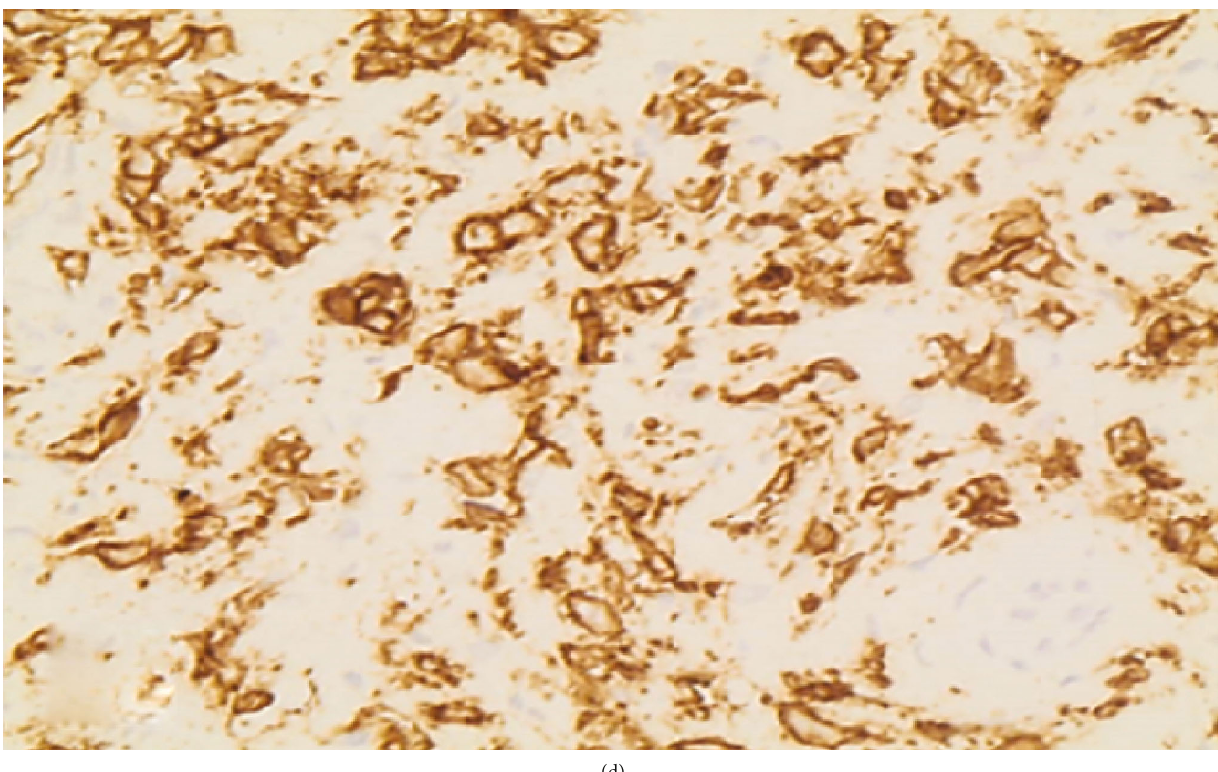
Figure 1: Pathology examination. (a) EE 4x; (b) 4x, immunohistochemical for CK, AE1-AE3: esocervical epithelium is strongly positive; (c) EE 10x, di ff use proliferation of large lymphoid cells with fi brous stromal reaction; (d) 10x, immunohistochemical for CD20: large lymphoid cells are strongly